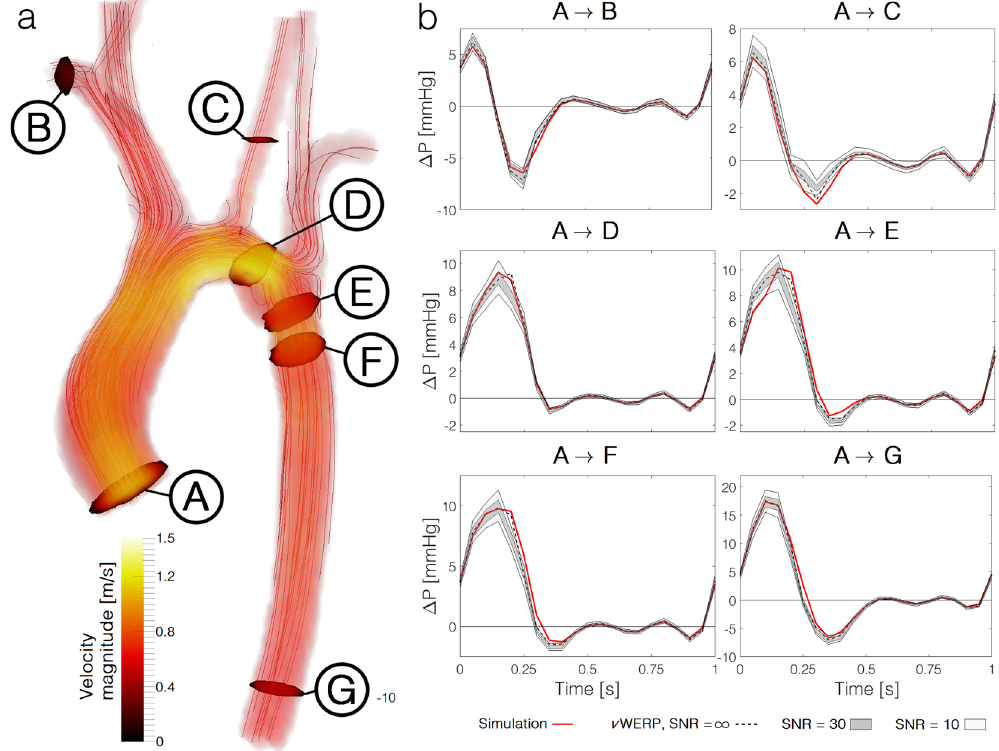
Figure 3. ν WERP relative pressure estimation in a patient-specific coarcted aorta. (a) Visualisation of velocity magnitude with streamlines, along with all selected inlet and outlet planes indicated by A – G. (b) Relative pressure estimations from aortic inlet (A) to all selected outlet planes (B – G) as a function of time. True pressure from simulations is given by the red continuous line, ν WERP estimates given by the dashed black, dark gray, and light gray fields, for SNR = ∞ /30/10,